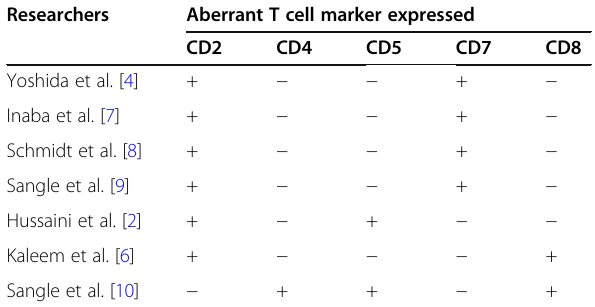
Table 1 Aberrant T cell marker expression in B cell lymphomas